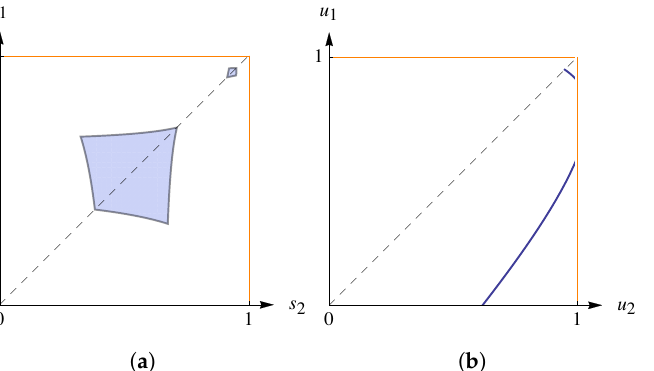
Figure A7. Plots ( a , b ) depict all ESDs and all symmetric equilibria for G D 1 ,